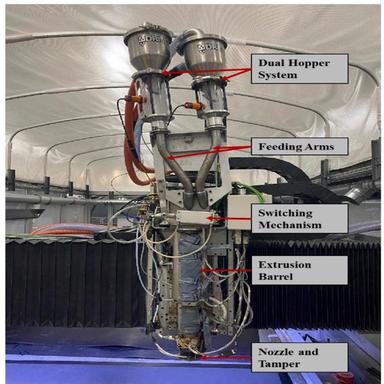
Dual-hopper mechanism installed on the BAAM system.